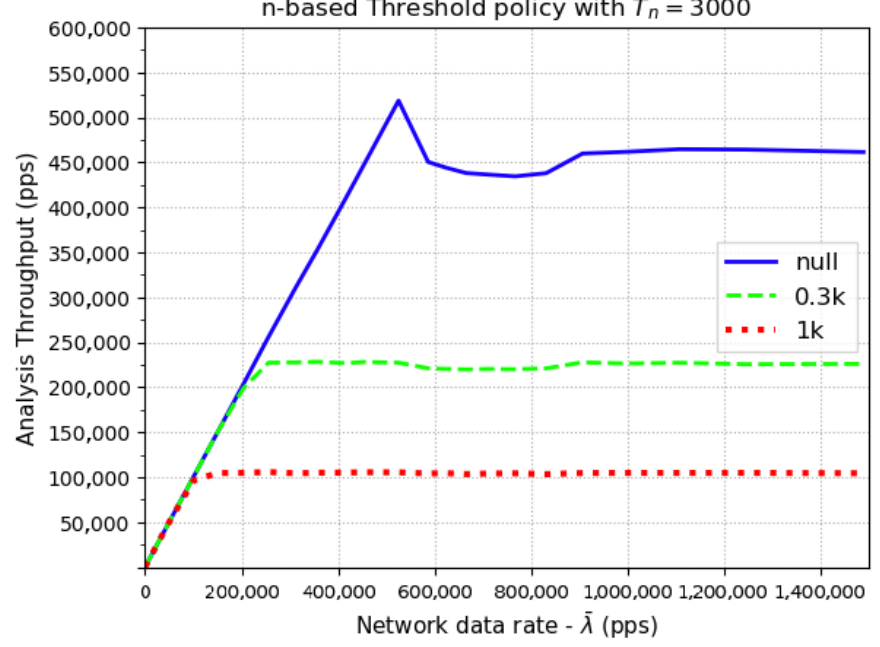
Figure 10. Performance simulation for n-based threshold